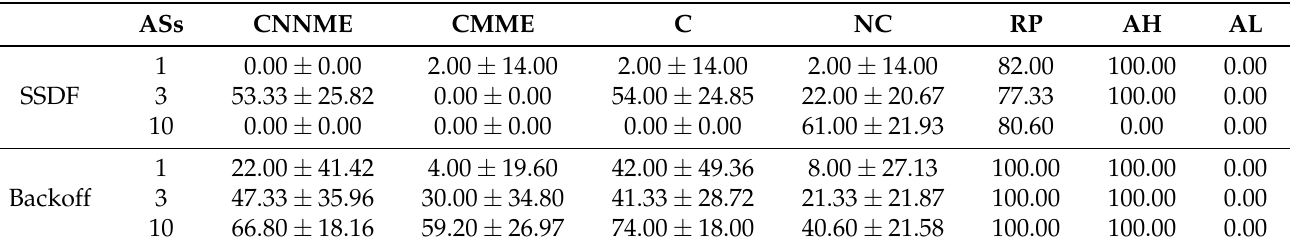
Table 3. Proportion of agents detected as ASs by the defense mechanism for each combination of attack, number of ASs and setup. The values were obtained averaging 50 episodes for the best seed of each policy after training. We show the average proportion ± one standard deviation.